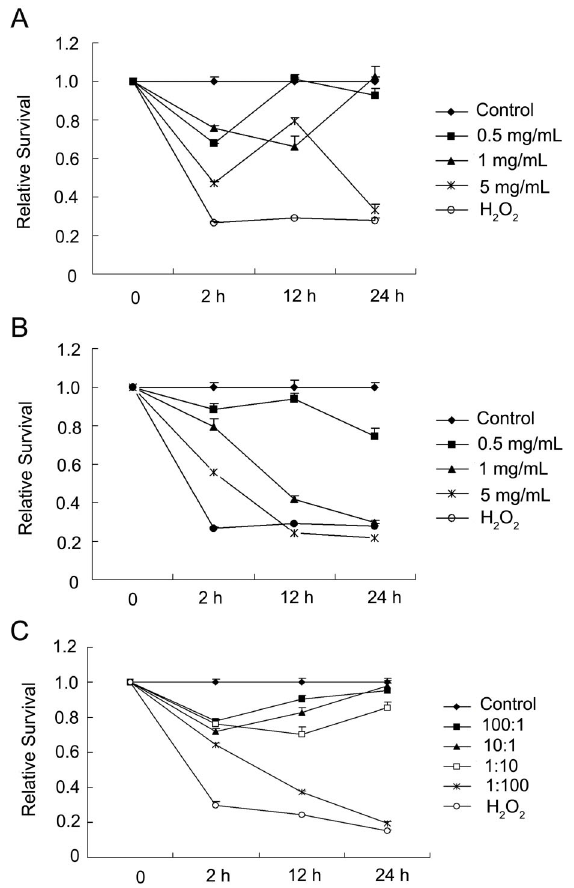
Figure 1. Cytotoxic effects of melamine, cyanuric acid (CA), and melamine and CA co-exposure on 293 cells. The 293 cells were treated with different concentrations of melamine, CA, and melamine-CA at different ratios (0.5 mg/mL) for p 24 h and cell viability was measured by the MTT test. A , Melamine alone; ( B ) CA alone; and ( C ) melamine-CA co - exposure. Data are reported as means ±